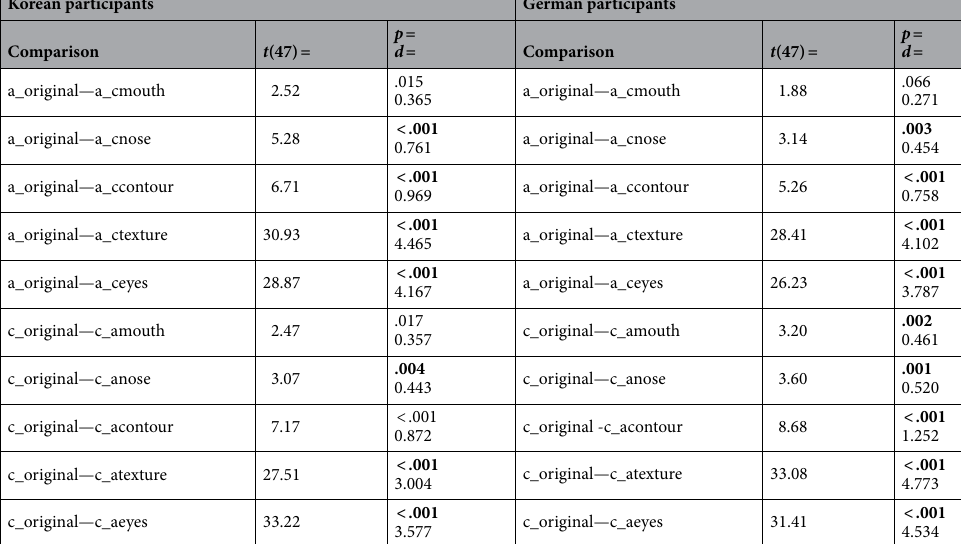
Table 1. Paired t-tests comparing categorization responses for the original parent faces to responses for their face variations. Significant p-values after Bonferroni correction for multiple significance tests (n = 10) are shown in bold. a_original: Asian parent, a_cmouth: Asian face with Caucasian mouth, a_cnose: Asian face with Caucasian nose, a_ccontour: Asian face with Caucasian contour, a_ctexture: Asian face with Caucasian texture, a_ceyes: Asian face with Caucasian eyes, c_original: Caucasian parent, c_amouth: Caucasian face with Asian mouth, c_anose: Caucasian face with Asian nose, c_acontour: Caucasian face with Asian contour, c_ atexture Caucasian face with Asian testure, c_aeyes: Caucasian face with Asian